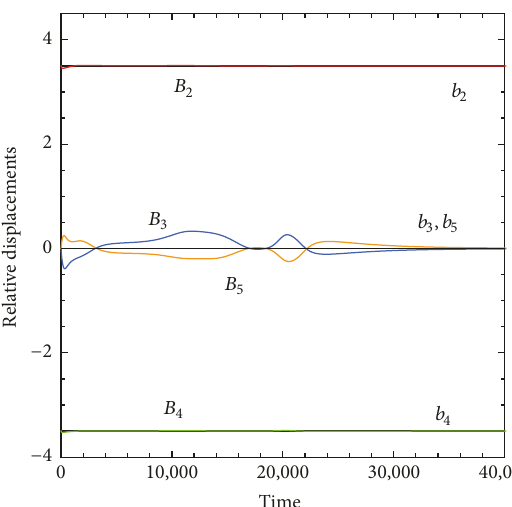
Figure 16: Relative distance error, 𝐵 𝑘 to 𝑏 𝑘 for Scenario